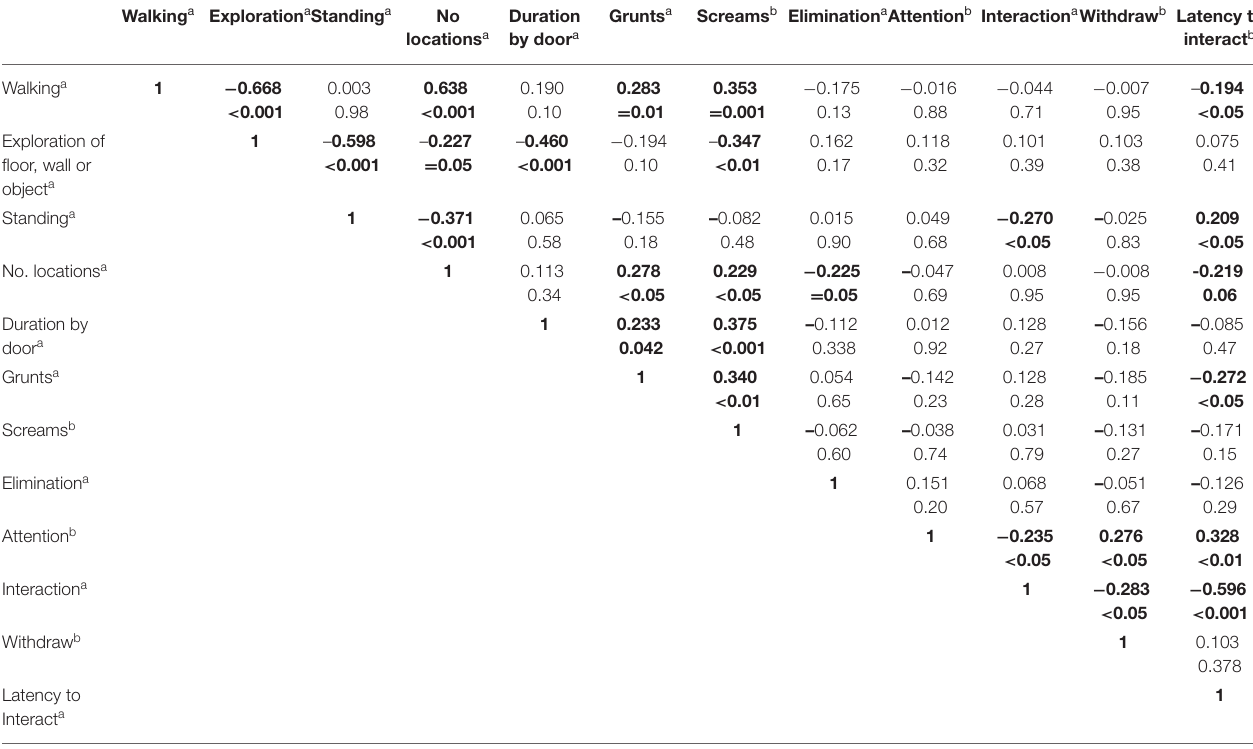
TABLE 3 | Correlations between the behaviors measured in the open field and novel object tests.